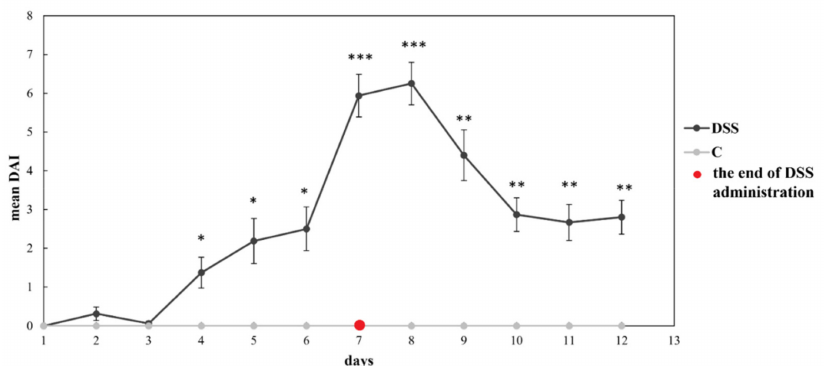
Figure 1. Disease activity index (DAI). Data are expressed as mean ± SEM (* p < 0.05, ** p < 0.01 and